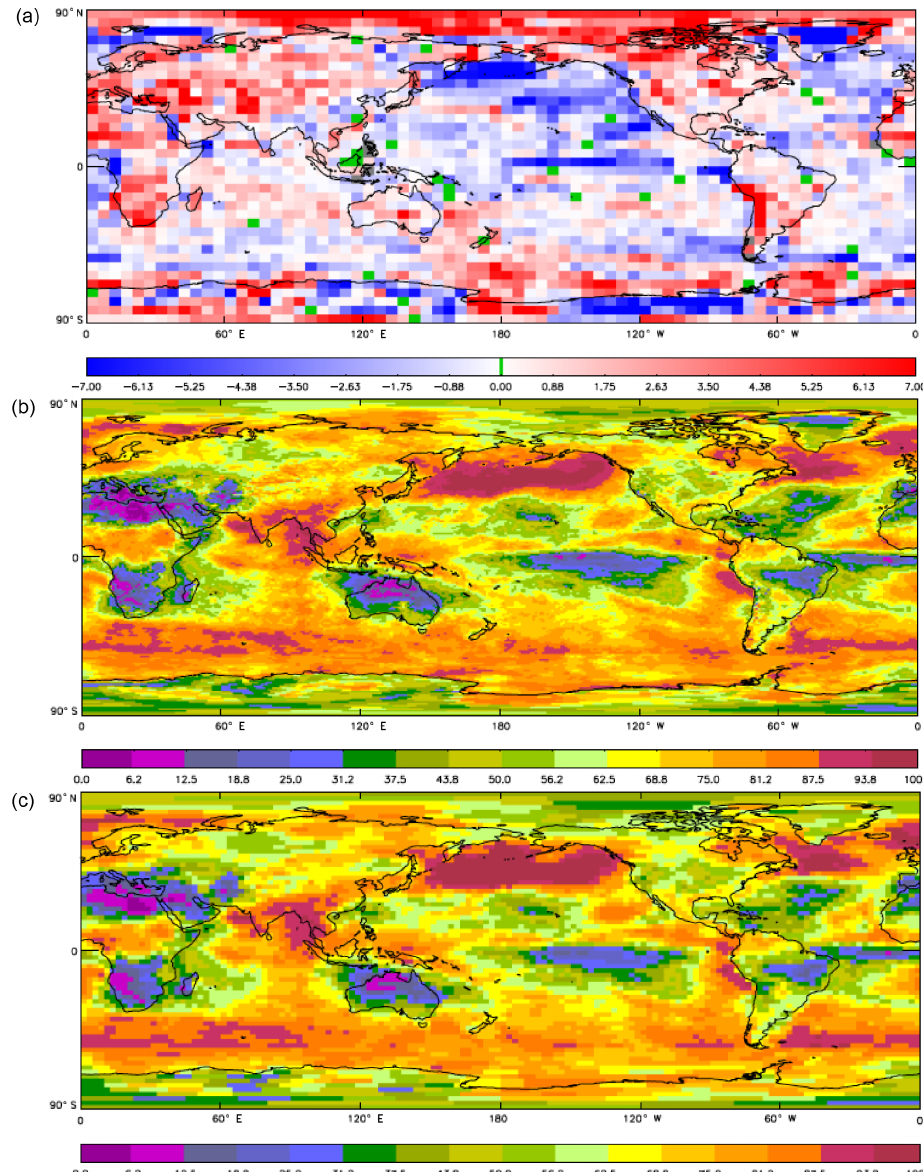
Figure 3. January 2009 ISCCP percentage of global cloud amount for (a) differences between H- and D-series, (b) H-series HGM product at 1 ◦ and (c) D-series D3 product at 2.5 ◦ . As shown, in (a) the differences between the products are greatest in the polar and coastal regions where for this case the H-series product has a slightly higher cloud fraction. In general, the H- and D-series distributions of cloud amount have good